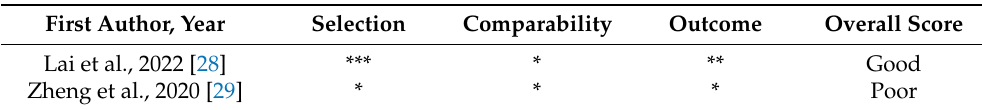
Table 2. Quality assessment of the included papers with the Newcastle-Ottawa Quality Assess- ment